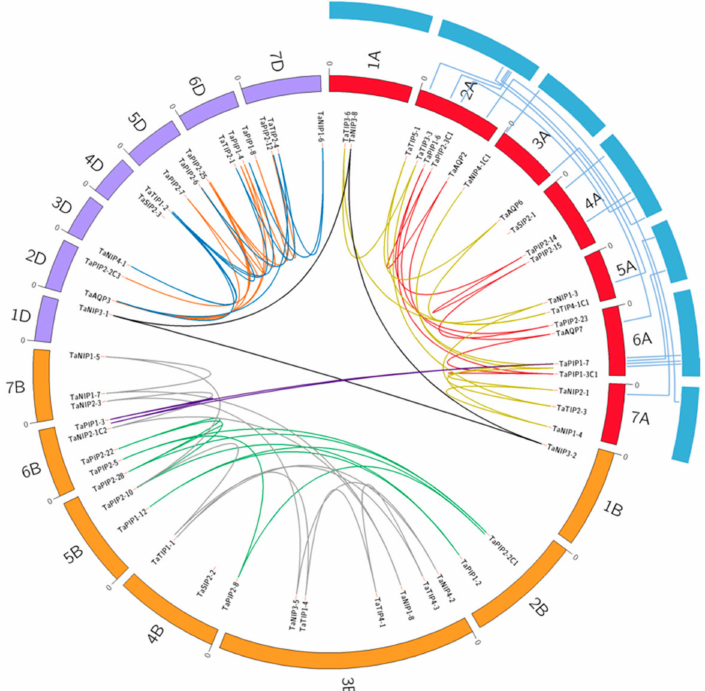
Figure 4. Analysis of synteny and chromosomal distribution of duplicated AQP genes of T. aestivum homolog groups and collinearity among AQP genes from T. aestivum and T. urartu . The locations of AQP genes are indicated on respective A, B and D sub-genomes of T. aestivum . Eight paralog groups are displayed in different colors. The light blue on the periphery represents chromosomes of T. urartu . The collinearity among TuAQPs and TaAQPs genes is represented by the lines between orthologue